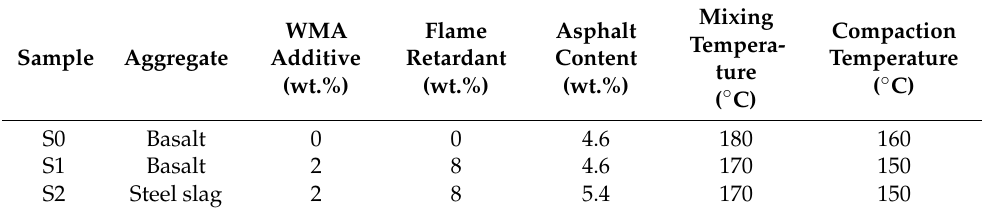
Table 6. Composition and preparing temperatures of different asphalt concrete.